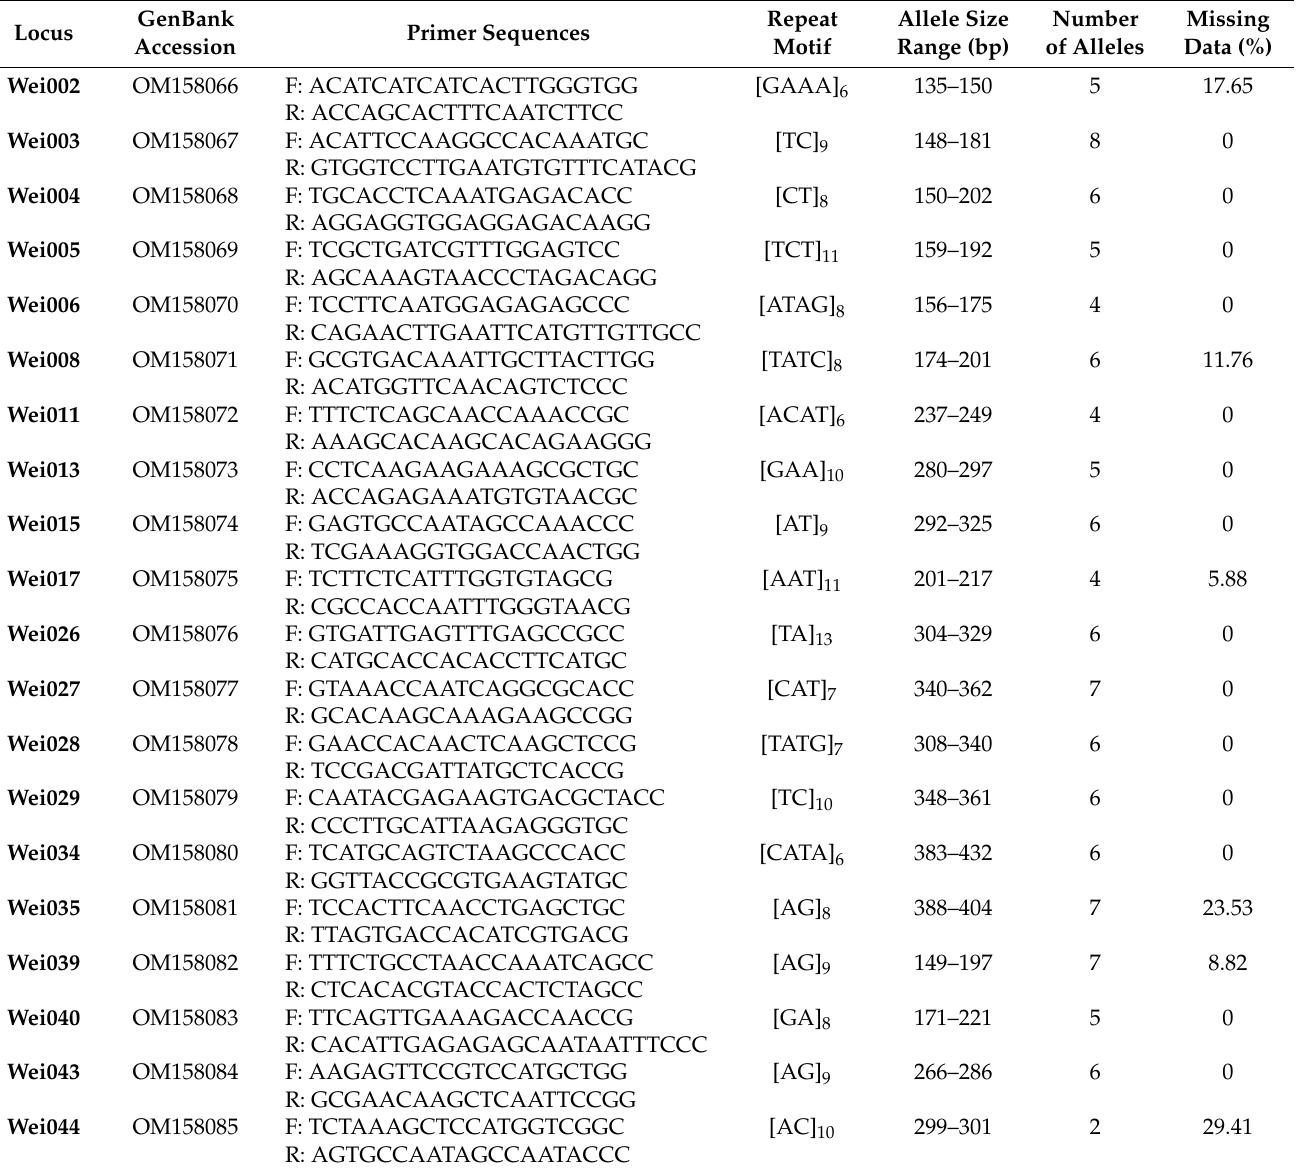
Table 1. Characteristics of the 20 genomic SSRs (gSSRs) developed for Weigela